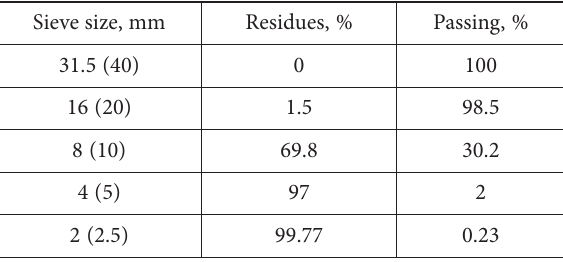
Table 4. The results of grading crushed gravel